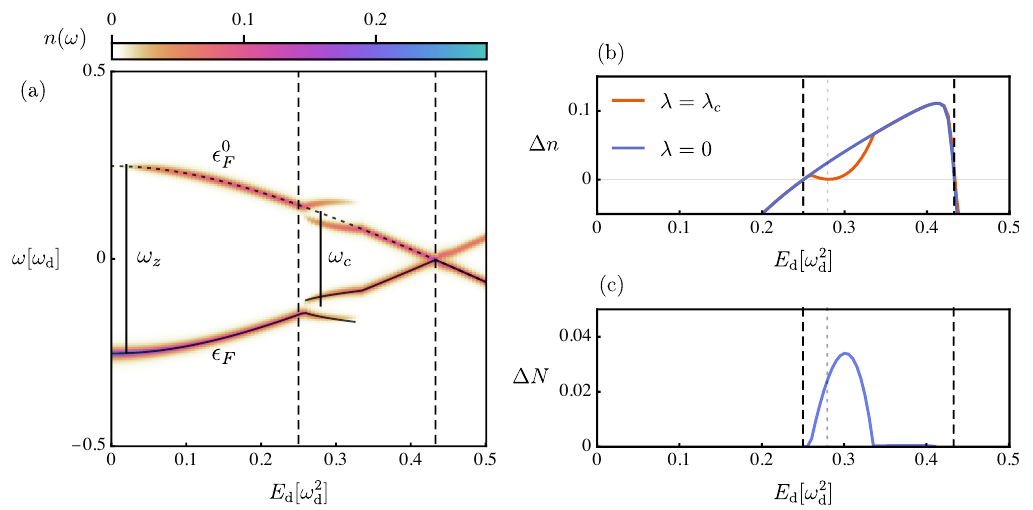
Figure 3: In panel (a) we show the Floquet state population n ( ω ) as a function of the driving field strength E calculated in the Schwinger formalism. The dotted line d indicates the Floquet energies ε 0 for λ = 0, the solid lines indicate the approximate F Floquet energies ε for λ = λ which we obtain from Eq. 21. In panel (b) we show F c the effective population difference ∆ n between Floquet states for λ = 0 (blue) and λ = λ (red). The regime in which population inversion occurs also contains the FSP, c which depletes the inversion. In panel (c) we show the difference ∆ N between the two populations in panel (b). The dashed lines in all panels indicate the values of E that bound the regime in which population inversion occurs, see Eqs. 25 and 26. d The dotted gray lines in (b) and (c) indicate the driving field strength at which the Floquet energy difference ∆ ε 0 is resonant with the cavity frequency ω F